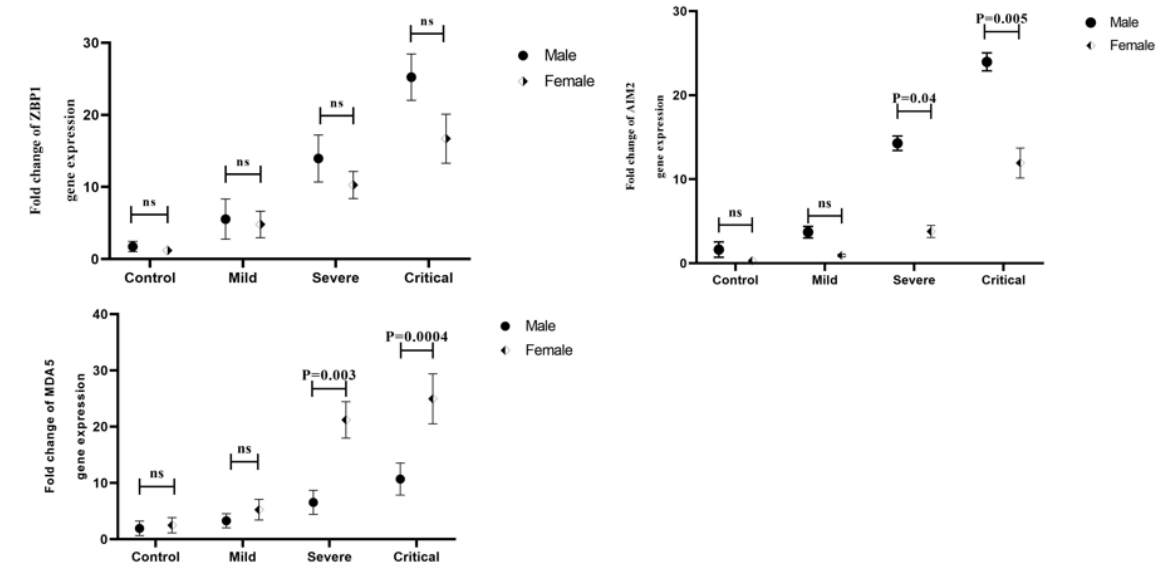
Figure 3: Comparison of ZBP1 A) , AIM2 B), and MDA5 C) gene expression levels between male and female patients in different outcomes of the disease. Data are presented as fold change. ns: not signif- icant. There are differences between specified groups (p <